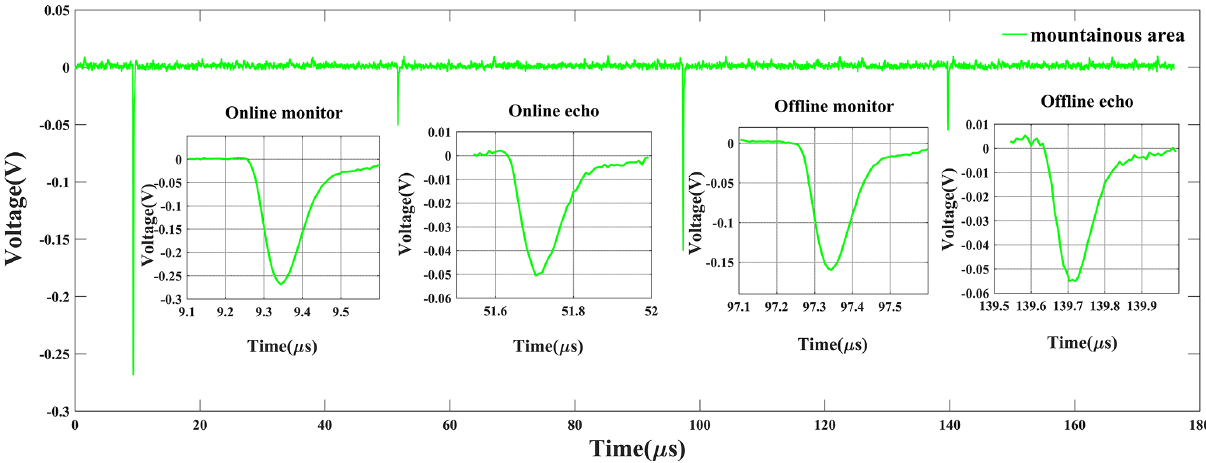
Figure 6. Original echo signal of mountain area (total signal and pulse amplification signal). The amplification signals from left to right are online monitor signal, online echo signal, offline monitor signal, and offline echo signal.